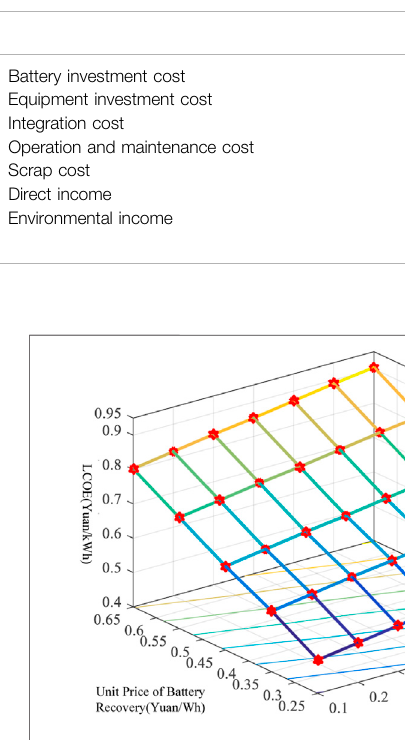
TABLE 4 | Annual investment costs and bene fi ts of decommissioning power batteries.